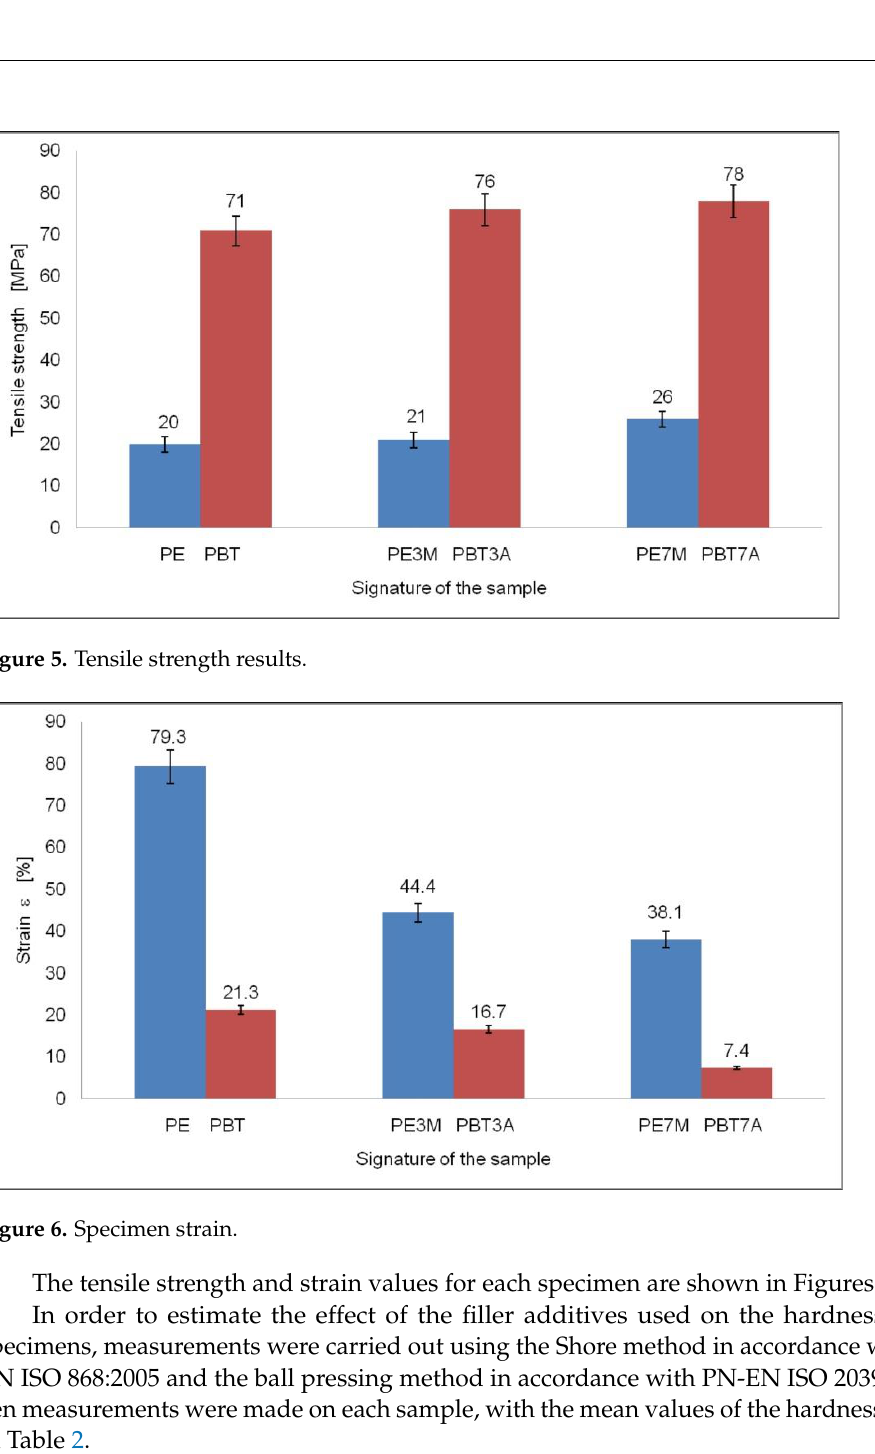
Figure 6. Specimen strain. Table 2. Harnesses measured by the Shore durometer and the ball indentation Table 2. Harnesses measured by the Shore durometer and the ball indentation method. Specimen